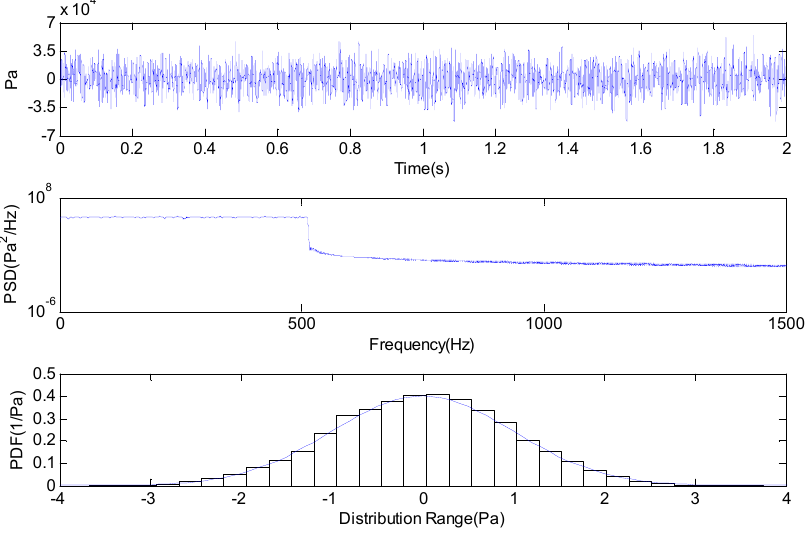
Figure 3. Random noise loading of generation (150 dB).